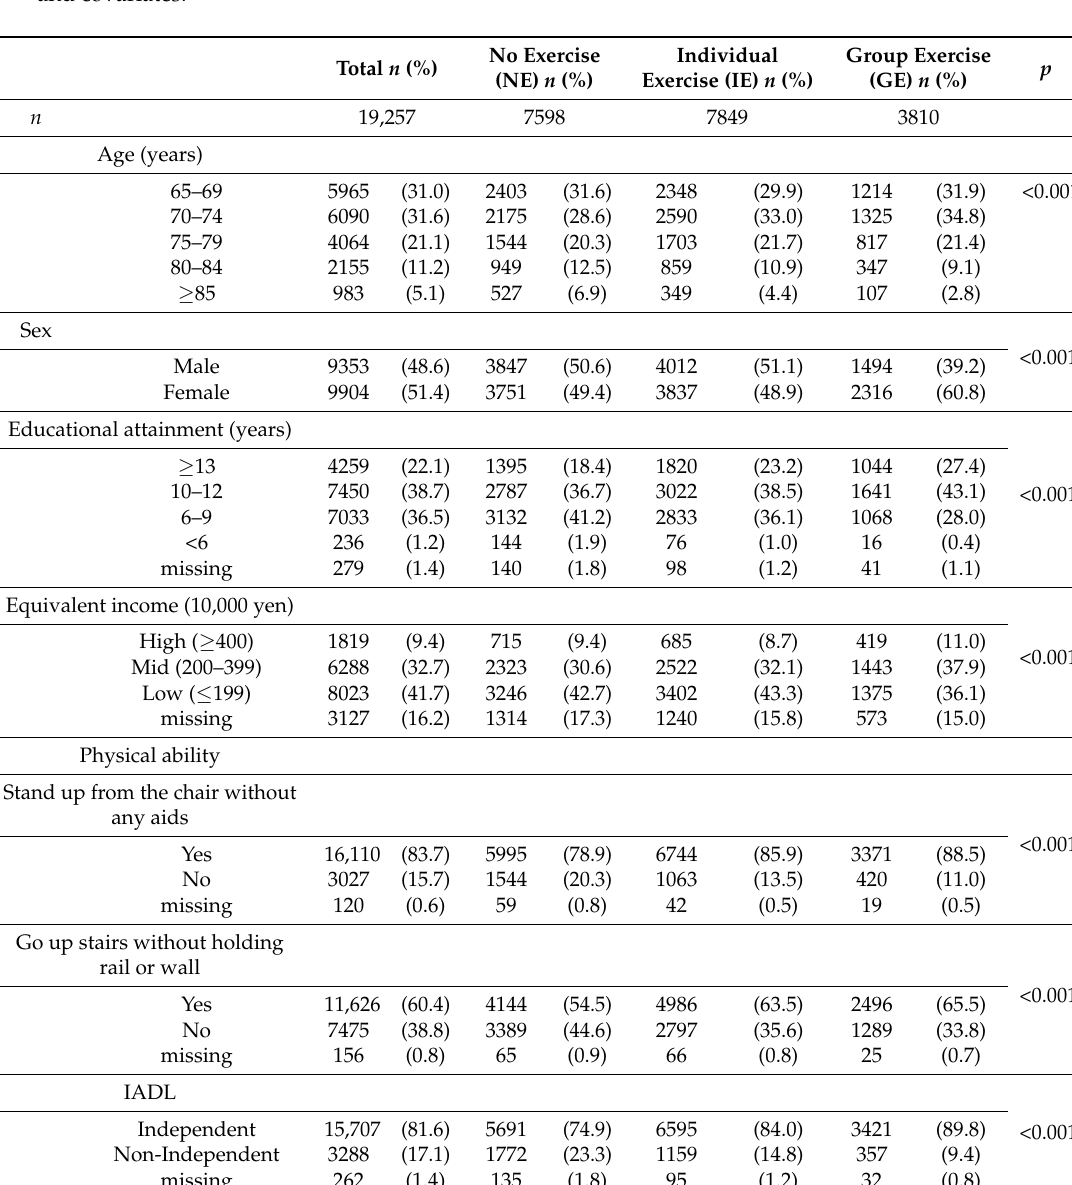
Table 2. Respondents’ baseline characteristics and univariate associations between type of exercise and